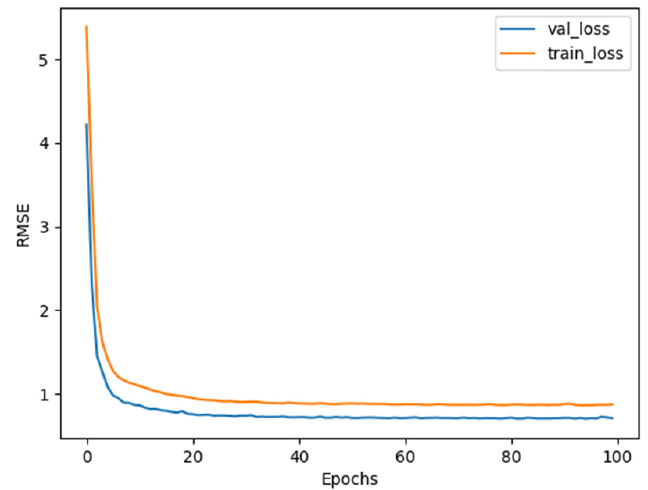
Figure 8. The learning curve of the Multi-Task-GH model.